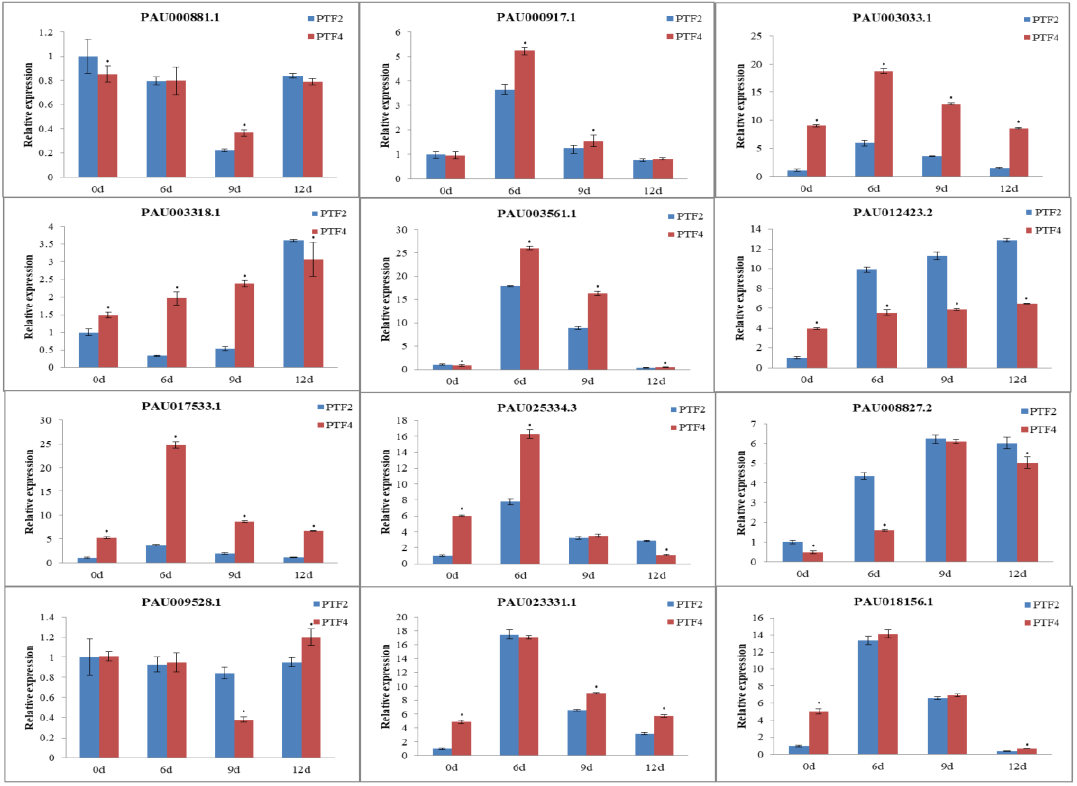
Figure 6. Relative expression levels of candidate drought response genes in two P. fortunei genotypes. 18S rRNA was used as the endogenous reference gene. Bar = Standard deviation. The difference between the diploid and autotetraploid P. fortunei within each drought treatment time point was significant (*, p < 0.05) according to the t -test. 0d, well-watered diploid and autotetraploid plants; 6d, 6 days drought-treated diploid and autotetraploid plants; 9d, 9 days drought-treated diploid and autotetraploid plants; 12d, 12 days drought-treated diploid and autotetraploid plants.